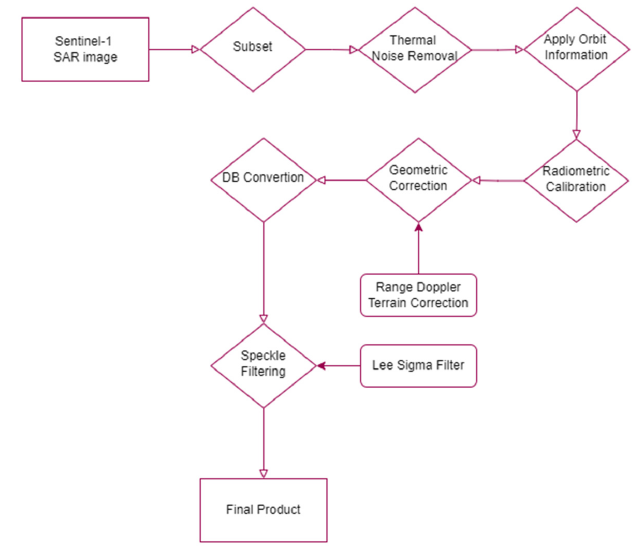
Figure 2. Pre-processing workflow of SAR images.